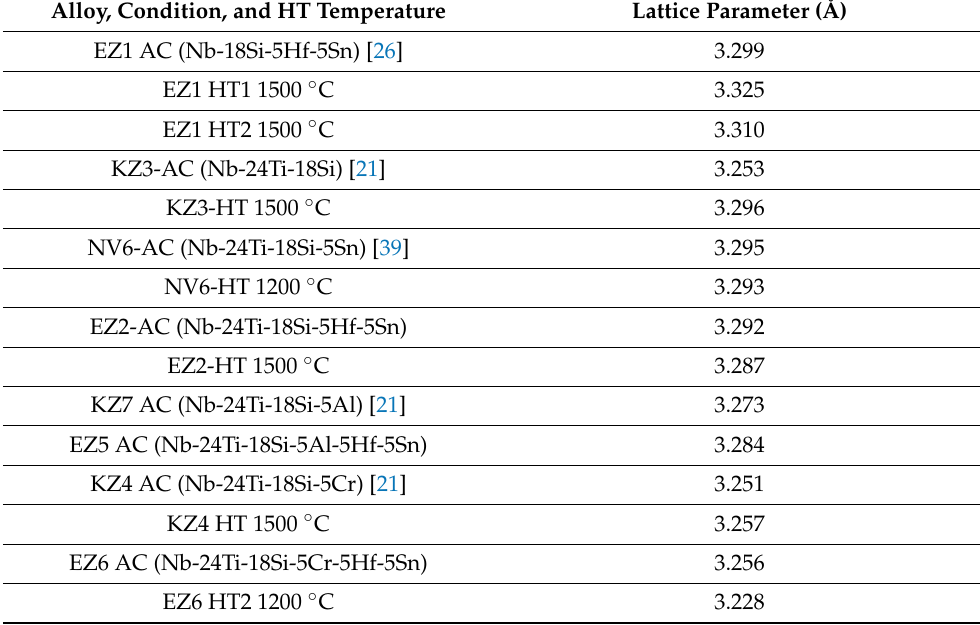
Table 5. Lattice parameter (Å) of the bcc Nb ss in Nb-18Si silicide-based alloys. Alloy, Condition, and HT Temperature Lattice Parameter